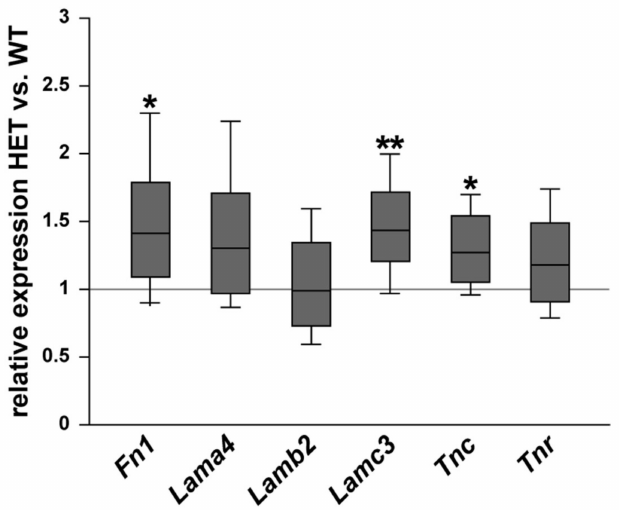
Figure 1. Increased Fn1 , Lamc3, and Tnc mRNA expression levels in the glaucomatous retina of HET mice. Relative expression of ECM glycoproteins in WT and HET retinae was determined by RT-qPCR. Our results showed a significantly increased Fn1 , Lamc3 and Tnc expression in the HET retina. Both groups showed a comparable Lama4 , Lamb2, and Tnr expression. Groups were compared using a pairwise fixed reallocation and randomization test. Data are shown as median ± quartile ± minimum/maximum. * p < 0.05, ** p < 0.01. n =